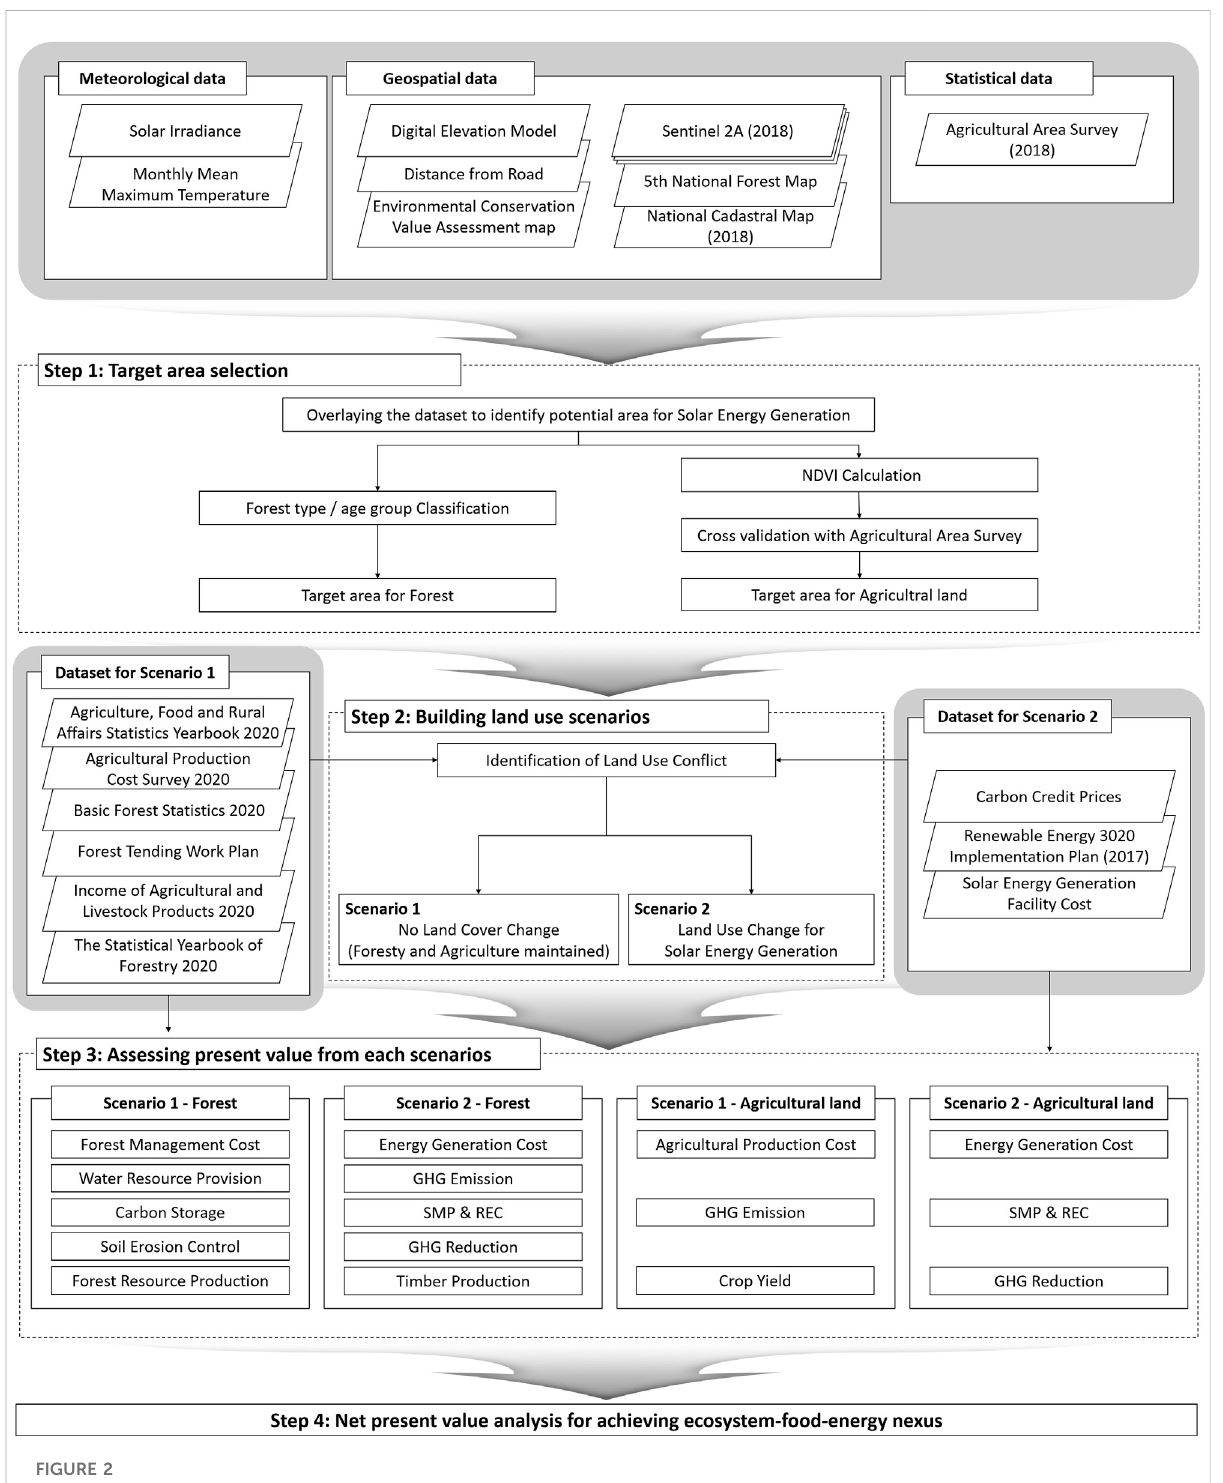
FIGURE 2 The overall research fl ow of this